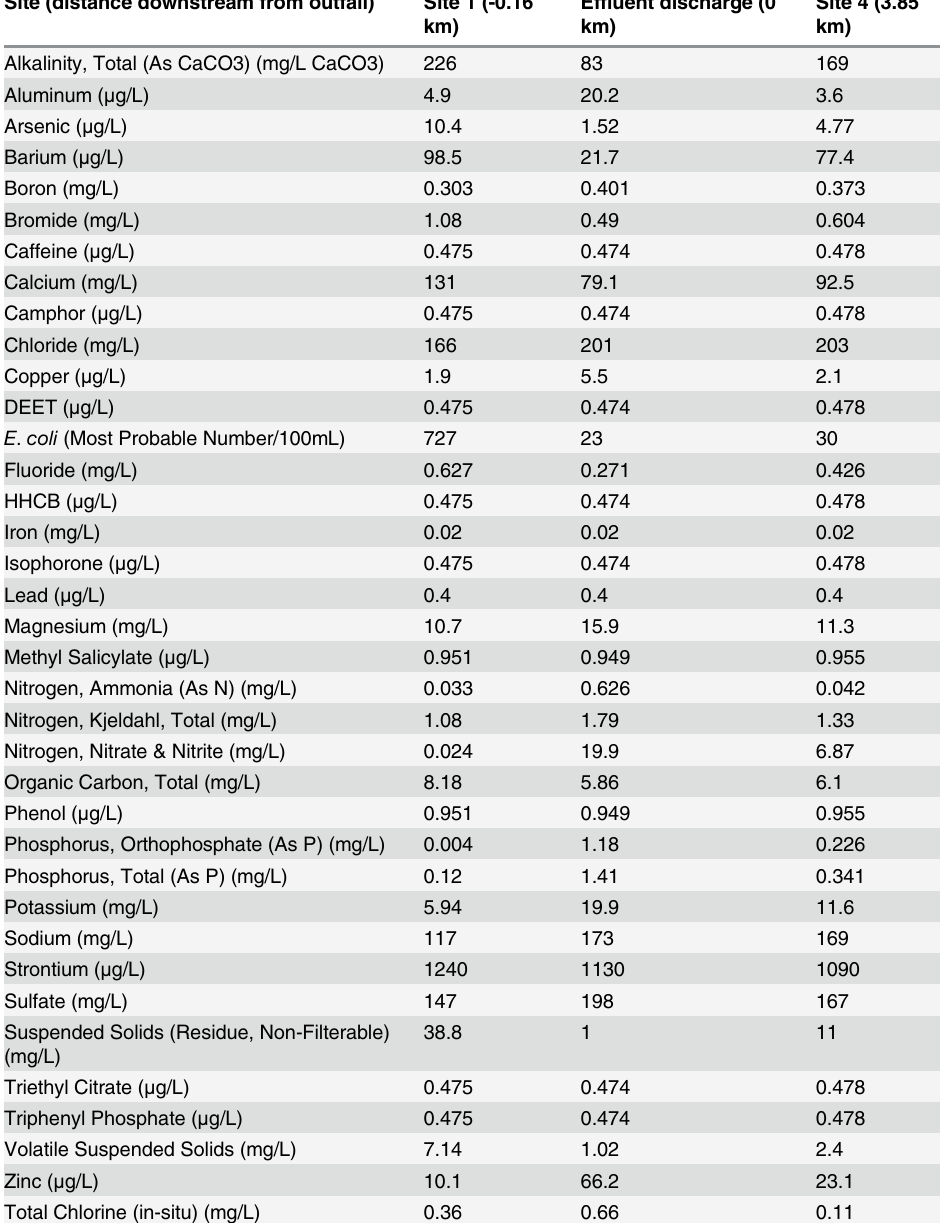
Table 6. Results of post-study water quality analysis of 37 nutrients and potential pollutants collected on 6-6-12 from Site 1 (0.06 km upstream of outfall), undiluted effluent, and Site 4 (3.85 km downstream of